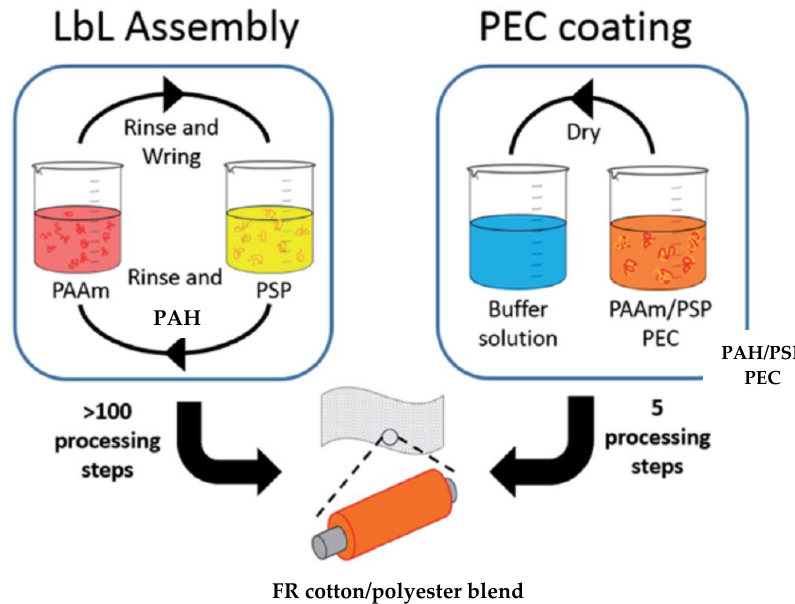
Figure 8. LbL and “one pot” deposition scheme of cotton/polyester fabric with PAH and PSP [143] Reproduced with permission from Haile, M.; Leistner, M.; Sarwar, O.; Toler, C.M.; Henderson, R.; Grunlan, J.C., RSC Adv.; published by Royal Society of Chemistry, 2016. Leistner et al. investigated the influence of low-molecular-weight additives (e.g., mel- amine) into the cationic CH network for effective FR properties of cotton/polyester blends coated with a 1.4 w% cationic CH solution and a 2 wt% anionic PSP solution. In this study,